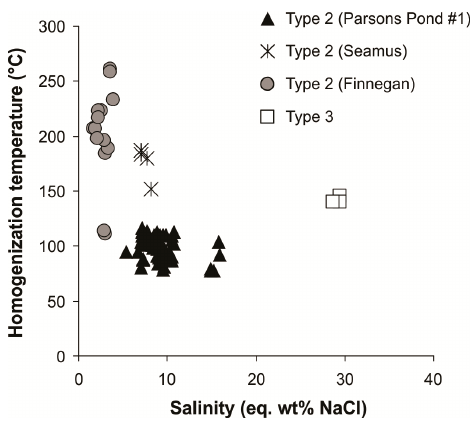
Figure 5. Bivariate plot of salinity vs. homogenization temperatures for Type 2 and Type 3 inclusions.